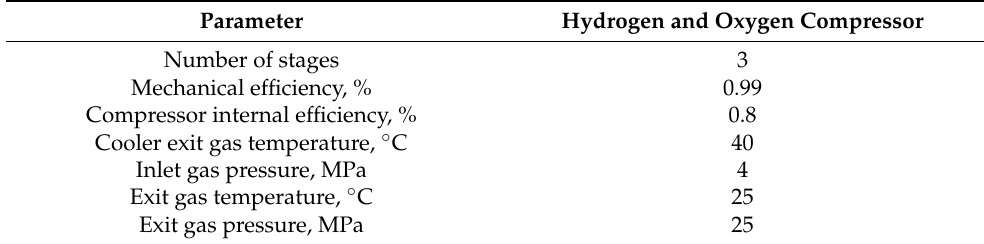
Table 4. Input data for the multi-stage compressor analysis.